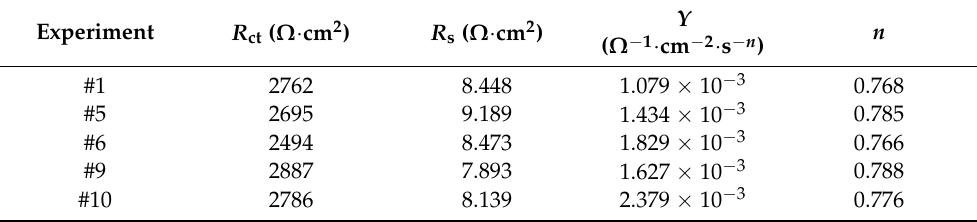
Figure 16. Polarization curves of samples obtained in comparative experiments: ( a ) #5 and #6, ( b ) #1 and #10, and ( c ) #9 and #10. Table 5. Fitted data of electrochemical impedance spectroscopy corresponding to Figure 15. Experiment